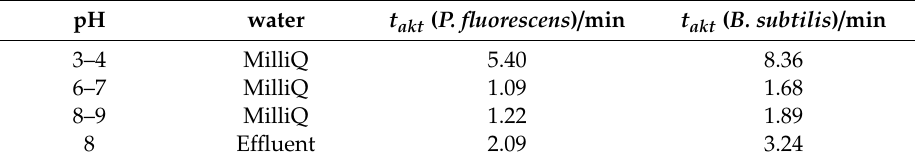
Table 7. Times t akt after which the e ff ectiveness of LOM against P. fluorescens and B. subtilis subsides on UVC irradiation, depending on pH and